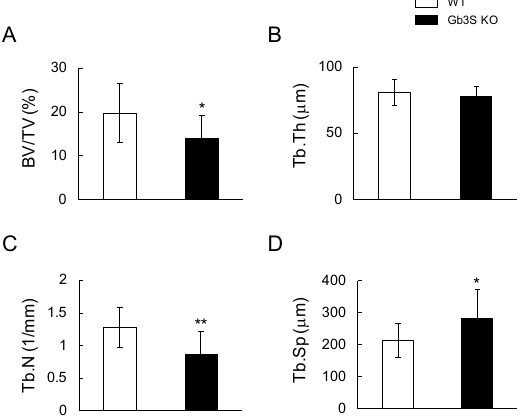
Figure 4. Attenuation of femoral cancellous bone mass in Gb3S KO mice. Analysis of bone densitometry of the distal region of the femur in WT and Gb3S KO mice by 3D- µ CT. Fifteen week-old mice (male, n = 12 for WT, n = 11 for Gb3S KO). ( A ) Bone volume / total volume (BV / TV, %). ( B ) Trabecular thickness (Tb.Th, µ m). ( C ) Trabecular number (Tb.N, 1 / mm). ( D ) Trabecular separation (Tb.Sp, µ m). Data are expressed as mean ± S.D. The single and double asterisks indicate p < 0.05 and p < 0.01, respectively.